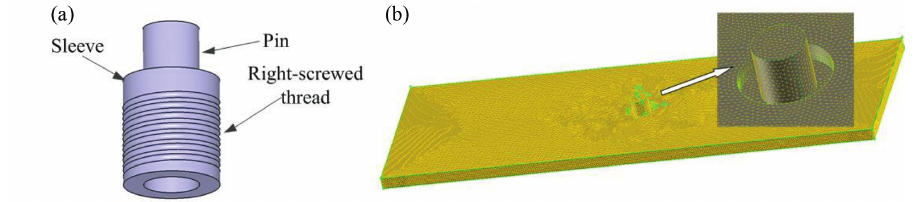
Figure 2: Model used in simulation: (a) tool and (b) mesh